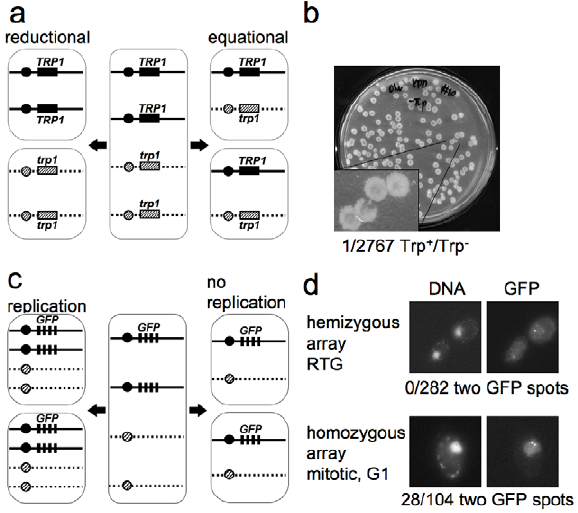
Figure 2. The first cell division after RTG involves equational chromosome segregation without replication. a. Outcome of different types of chromosome segregation after RTG. One homolog is shown as solid line and the other as dashed line. Black and diagonal hatched boxes indicate dominant TRP1 and recessive trp1 alleles, respectively. Reductional chromosome segregation (left) separates homologs, producing a sectored colony with TRP1 / TRP1 and trp1 / trp1 cells. Equational chromosome segregation (right) separates sister chromatids, producing homogenous TRP1 / trp1 colonies. b. Meiotic cells (MJL3163) were plated on YPD, inducing RTG, and 2767 colonies were replica-plated to medium lacking tryptophan. The single Trp + / Trp 2 colony observed is shown. c. Expected outcomes if DNA replication occurs or does not occur before the first nuclear division after RTG. A strain hemizygous for a CEN5-GFP array (black rectangles, see text for details) is illustrated. After 7 hr in meiosis, each cell includes two copies of CEN5-GFP (middle). Replication followed by equational chromosome segregation (left) results in two copies of CEN5-GFP in each cell. Equational chromosome segregation without prior replication (right) leaves a single copy of CEN5-GFP in each cell. d. Upper panel— post-mitotic cells with a hemizygous CEN5-GFP array (MJL3312), from a sample taken 3.5 hr after RTG. All 282 post-mitotic G1 cells examined had a single GFP spot. Lower panel—control cells with a homozygous CEN5-GFP array (MJL3313) growing vegetatively in YPD. An unbudded cell in G1 is shown. 28/104 G1 cells had two GFP dots. Left—Nuclei detected by DNA/DAPI fluorescence; right—GFP fluorescence.